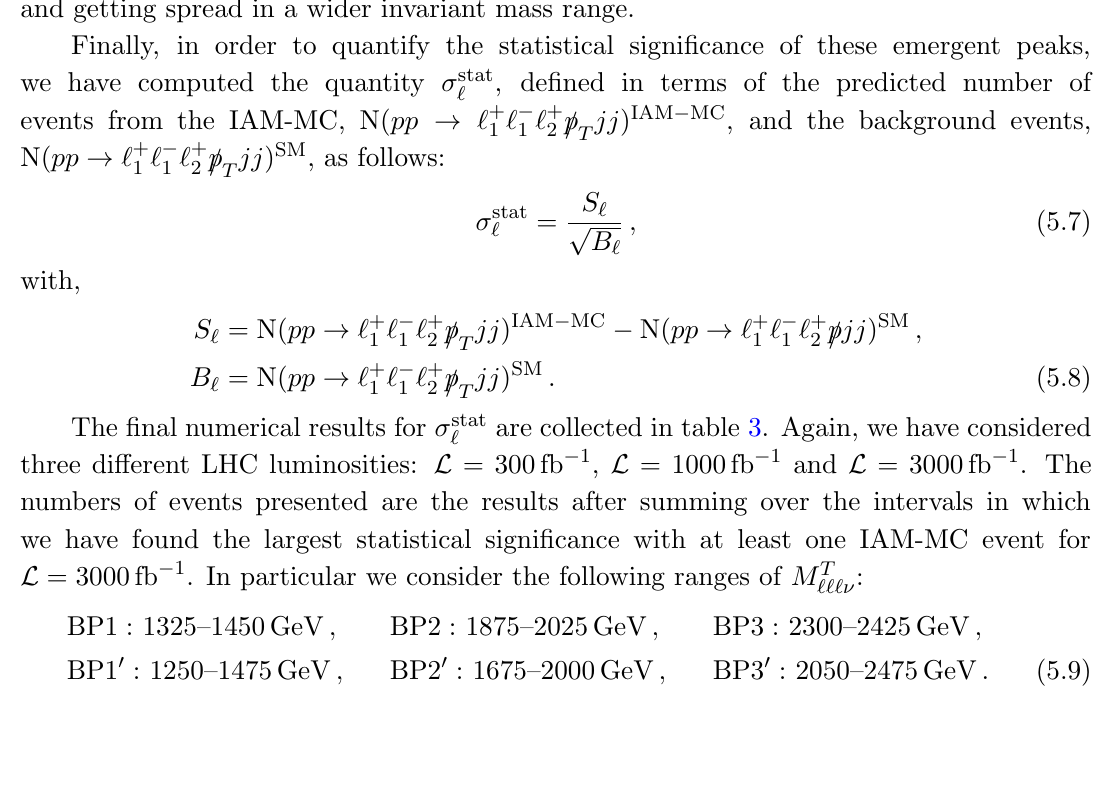
‘ + ‘ (cid:0) ‘ + (cid:23)jj events of the IAM-MC, N IAM (cid:0) MC 1 1 2 !